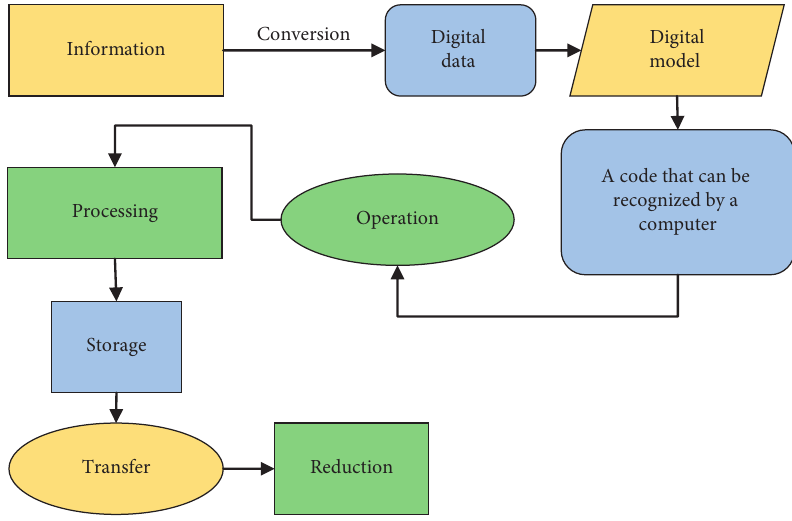
Figure 1: Schematic flow chart of digital technology.